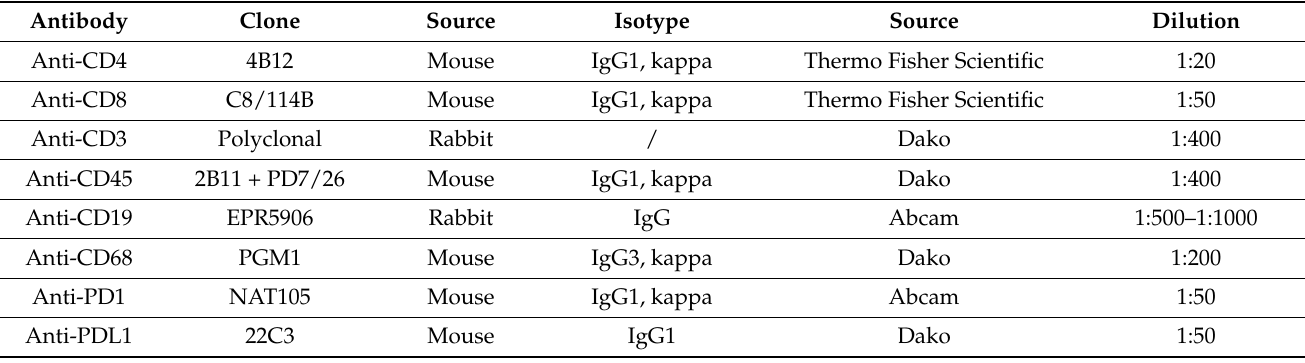
Table 3. List of antibodies used for protein